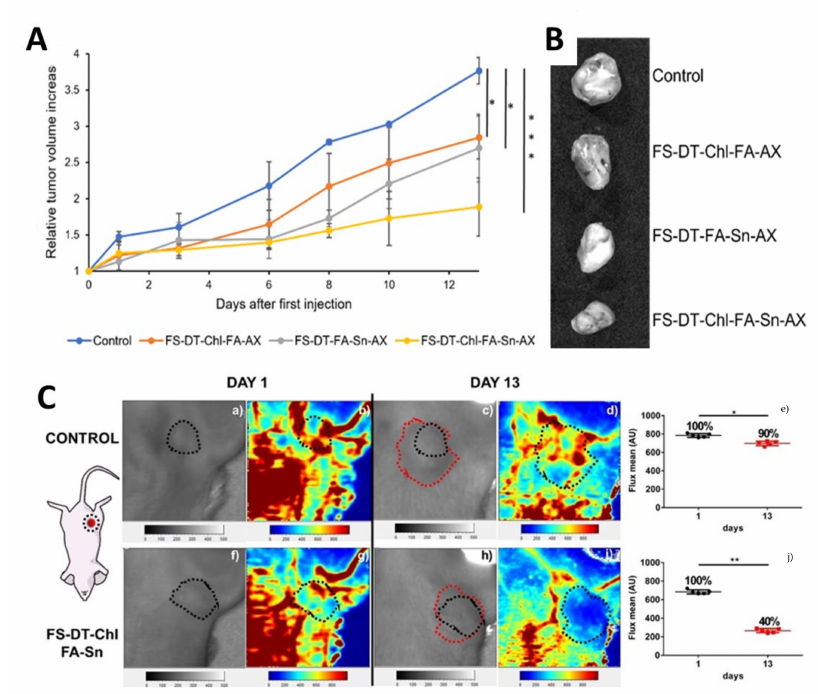
Figure 10. Evaluation of synergistic antitumor activity of theranostic nanoplatform in TNBC mice models. ( A ) Relative tumor volume increase during the treatment with the nanoparticles or placebo (control). ( B ) Ex vivo tumor images for all mice treated with silica nanoparticles or placebo. Sig- nificance was calculated by unpaired t -test of one-way ANOVA. *: p < 0.05 or significant statistical difference between the groups of data; ***: p < 0.001 or highly significant statistical difference between the groups of data. ( C ) Laser Doppler perfusion imaging (LDI) of tumor areas. ( a ) bright field image of control mouse, day 1 (black dotted line: tumor area at the beginning); ( b ) laser doppler imaging of control mouse, day 1; ( c ) bright field image of control mouse, day 13 (red dotted line: tumor area at the endpoint); ( d ) laser doppler imaging of control mouse, day 13; ( e ) comparison of blood perfusion in tumor area of control mouse; ( f ) bright field image of treated mouse, day 1 (black dotted line: tumor area at the beginning); ( g ) laser doppler imaging of treated mouse, day 1; ( h ) bright field image of treated mouse, day 13 (red dotted line: tumor area at the endpoint); ( i ) laser doppler imaging of treated mouse, day 13; ( j ) comparison of blood perfusion in tumor area of treated mouse. Significance was calculated by unpaired t Student test. *: p < 0.05 or significant statistical difference between the groups of data; **: p < 0.01 or highly significant statistical difference between the groups of data [91]. Copyright © Authors of the publication (open